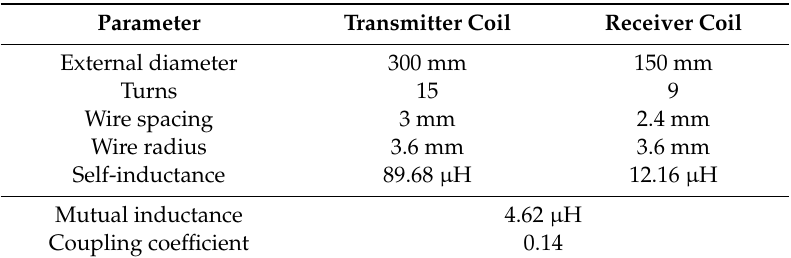
Table 2. Design parameters of the magnetic coupler.